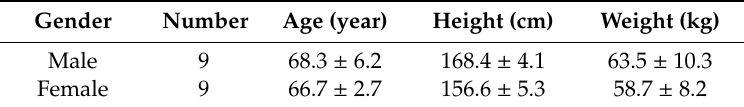
Figure 3. Experimental conditions. Table 1. Information of subjects [40].